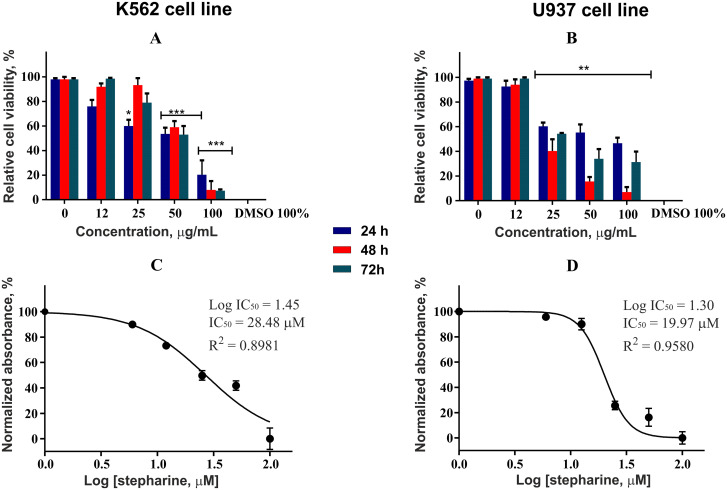
Cytotoxic activity of stepharine and respective IC50 values.